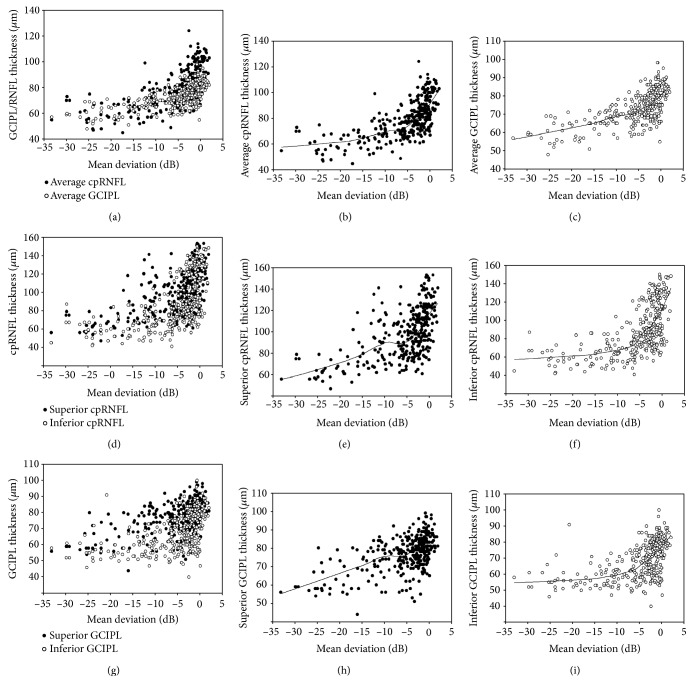
Scatterplot showing the average, superior, and inferior cpRNFL/GCIPL thicknesses according to glaucoma severity assessed using mean deviation (MD) in the study population.